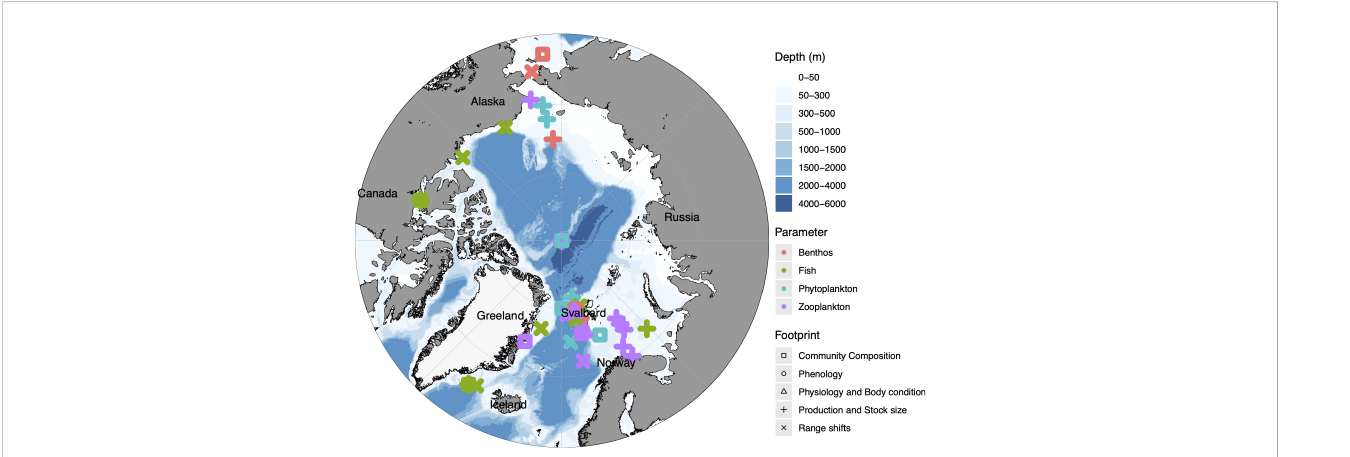
FIGURE 2 Map of the geographical distribution of primary footprints on a pan-Arctic scale Part 1 (Primary production, zooplankton, benthos, fi sh). The colours represent the different parameters, while the shapes represent the type of footprint. Please note that the geographical North Pole was chosen as a representative point for all pan-Arctic studies, therefore overlapping can occur. A summary of all relevant papers sorted by footprint types and parameters in Supplementary Tables